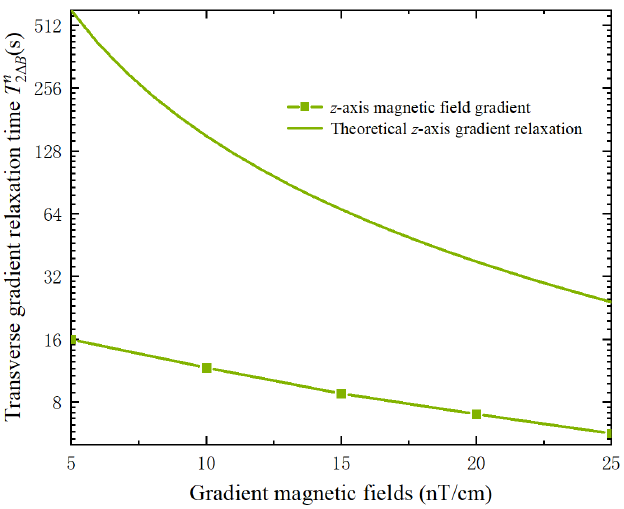
Figure 8. Measured relaxation times of transverse magnetic field gradients of inert atoms with z -axis magnetic field gradients applied alone and curves calculated from theoretical equations.